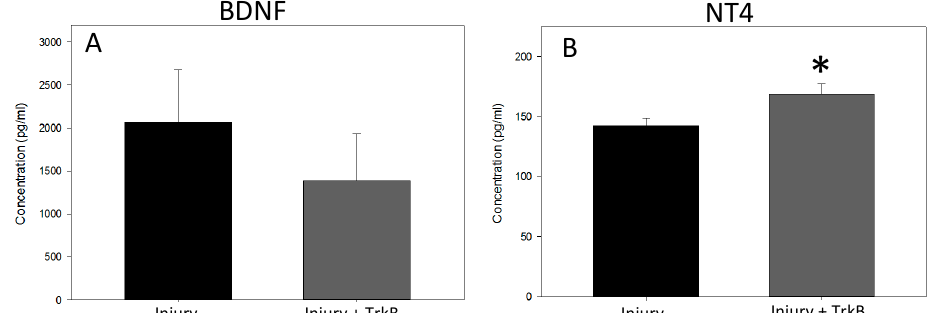
Figure 4. Effects of Tyrosine Kinase B functional chimera binding. Plasma concentration of unbound ( A ) brain-derived neurotrophic factor (BDNF) and ( B ) neurotrophin 4 (NT4) six weeks after pudendal nerve crush (PNC) and vaginal distension (VD) injury treated with saline (Injury), or PNC + VD injury treated with tyrosine kinase B (TrkB) fusion chimera (Injury + TrkB). Each bar represents the mean ± standard error of the mean of data from 8–12 animals in each group. A Mann–Whitney test was used to determine statistically significant differences. * indicates a statistically significant difference ( p < 0.05) between the groups.